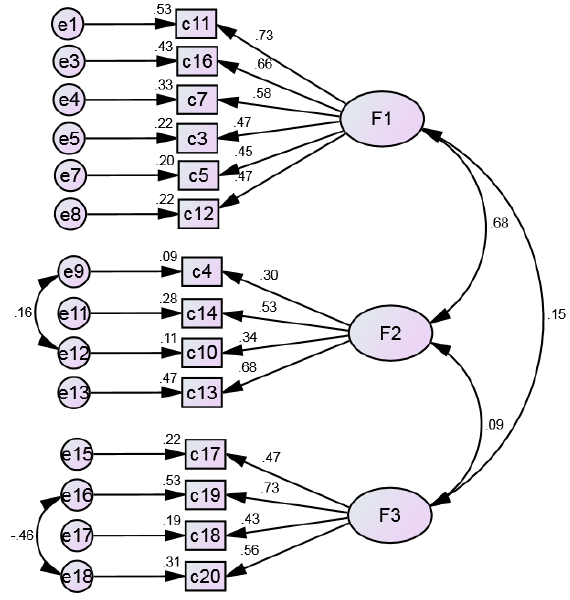
Figure 3. Final refined model with modification indices.